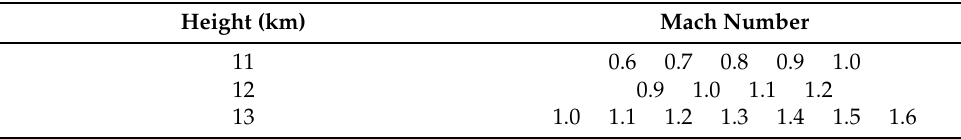
Table 2. Calculation status points in powered flight